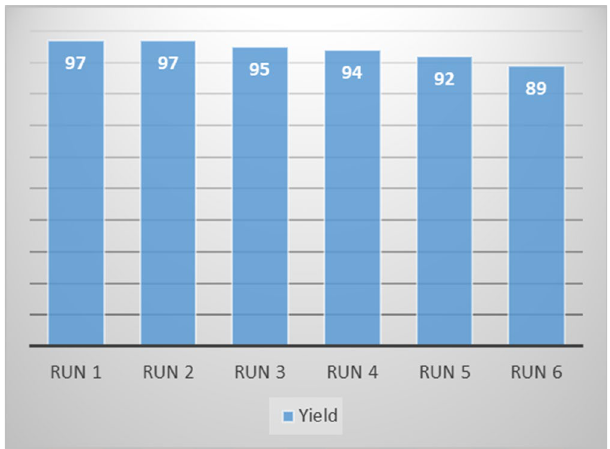
Figure 7. Reusability of Pd@Hal-DAB-PC.